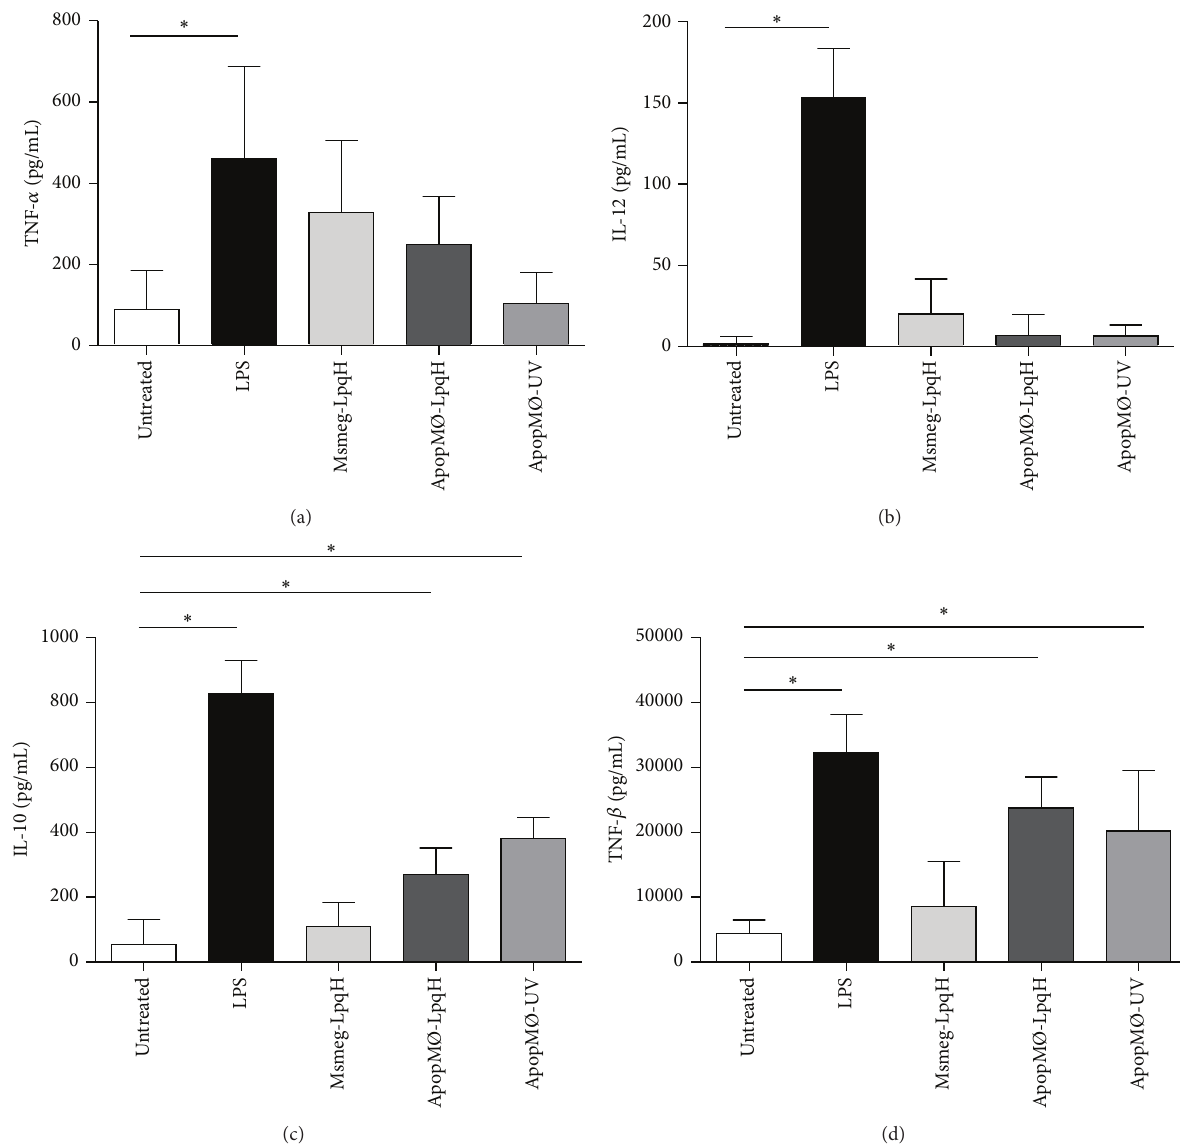
Figure 7: The phagocytosis of apoptotic MØs upregulates anti-inflammatory cytokines in macrophages. A total of 1 × 10 6 cells/mL were cocultured with 50 𝜇 g of apoptotic MØs for 24 h. The culture supernatants were collected and assayed for cytokines using ELISA. The data shown are from four independent experiments. Msmeg-LpqH, cells walls of transformed M. smegmatis that expresses LpqH. The statistical significance was determined by one-way ANOVA and Kruskal-Wallis test; ∗ 𝑝 < 0.05 .